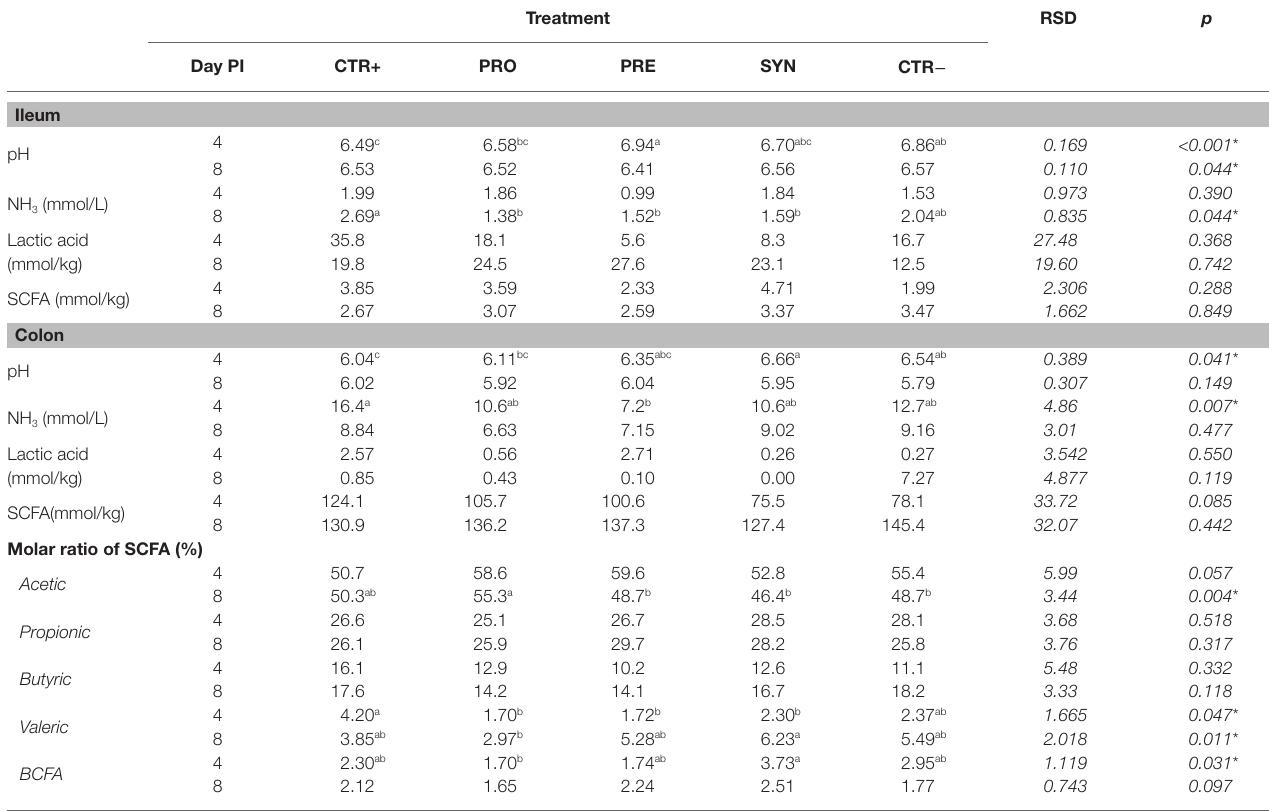
TABLE 5 | Effects of experimental treatments on ileal and colonic fermentation.